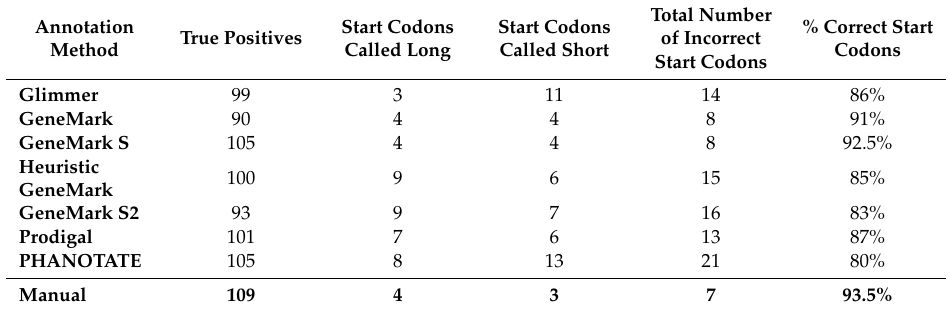
Table 4. Results of start codon identification in the genome of mycobacteriophage Patience. Host-trained GeneMark.hmm is omitted due to its anomalous results for this